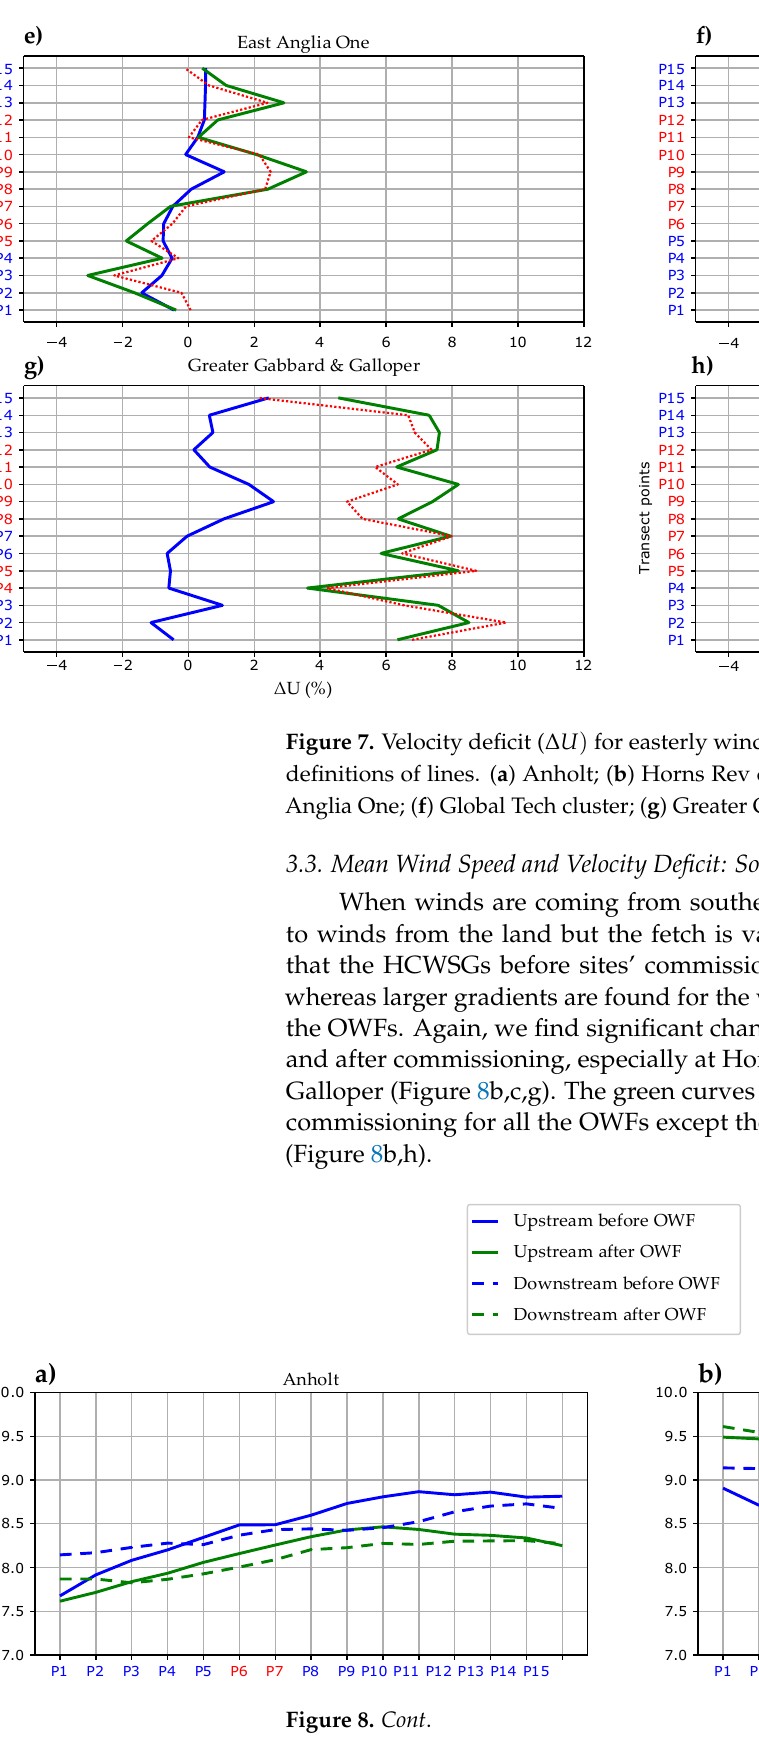
Figure 8. Mean wind speed ( 𝑈) for southerly winds over the OWFs and clusters. See Figure 4 for the line definitions. Note that the figure axes are different than for the corresponding plots for west- erly and easterly winds as we have chosen to match the layout of transects in Figure 3. ( a ) Anholt; ( b ) Horns Rev cluster; ( c ) Butendiek; ( d ) Nordsee cluster; ( e ) East Anglia One; ( f ) Global Tech cluster; ( g ) Greater Gabbard & Galloper; ( h ) Hornsea Project One. U ( m / s ) U ( m / s )